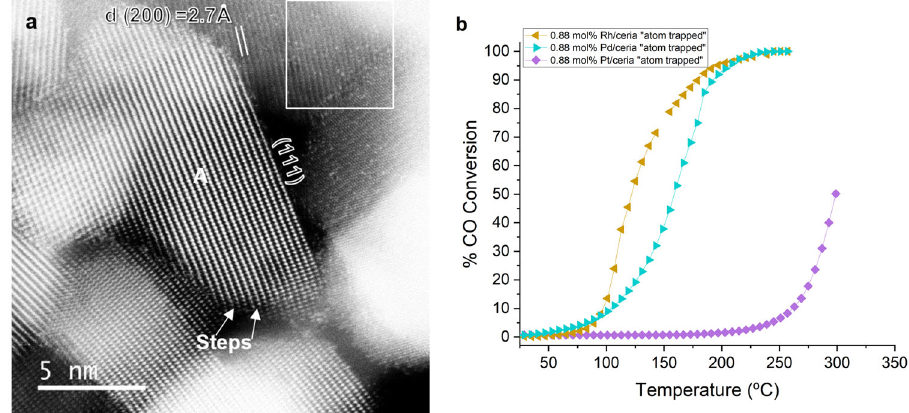
Fig. 1 Characterization of single-atom catalysts. a AC-STEM image of 3 wt% Pt/ceria prepared via atom trapping. Particle A is oriented along the [112] zone axis resulting in strong contrast from the Ce atom columns, while the ceria particle in the boxed region is oriented off the zone axis making it easier to detect the Pt single atoms, which appear as bright dots. The boxed region is 5 nm × 5 nm in size and contains 25 Pt atoms, consistent with the overall loading of 1 Pt atom/nm 2 . Surface steps are a common feature of ceria polyhedral particles and are likely sites for strong binding of Pt single atoms. The fi gure content is adapted with permission from Kunwar et al. 6 . Copyright (2019) American Chemical Society. b CO oxidation reactivity of Pt, Pd, and Rh single-atom catalysts prepared via atom trapping. The catalysts contain identical molar loading equivalent to 1 wt% Pt/CeO 2 (0.88 mol% of Pt, Pd, or Rh and 99.12 mol% CeO 2 ). The CO oxidation was performed using 20 mg of catalyst, with 1 ml/min of CO, 1.5 ml/min of O 2 , and 75 ml/min of helium. The samples were heated to 300 °C at 2 °C/min and cooled back down to room temperature in the reaction mixture to test for reproducibility. The data shown represent the third run. The catalysts are stable and each of them contain exclusively atomically dispersed metal species located on the surface of the ceria. The fi gure content is adapted with permission from Alcala et al. 12 . Copyright (2021) Elsevier,